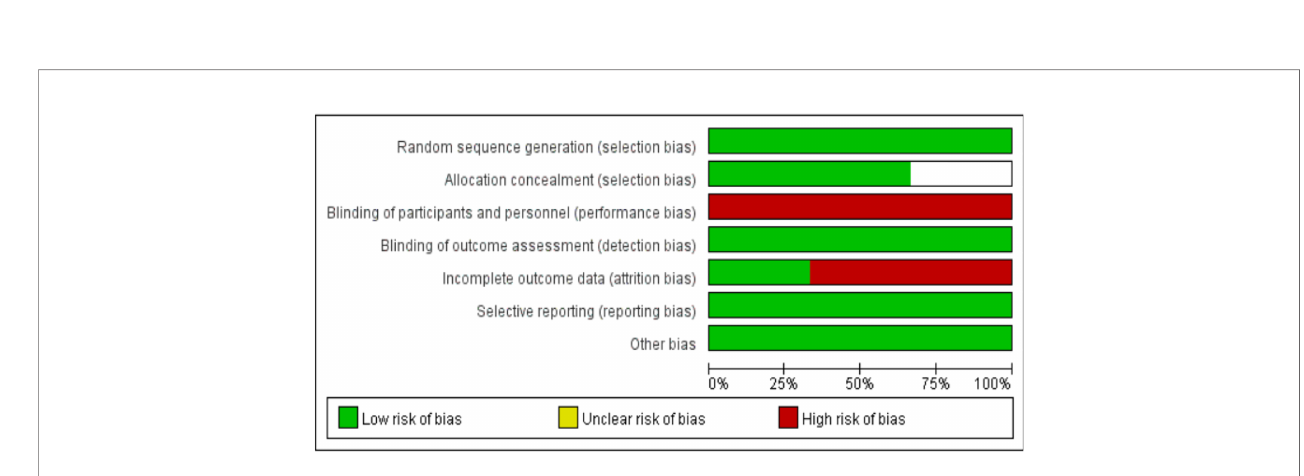
FIGURE 2 | Risk of bias assessment tool for included studies.